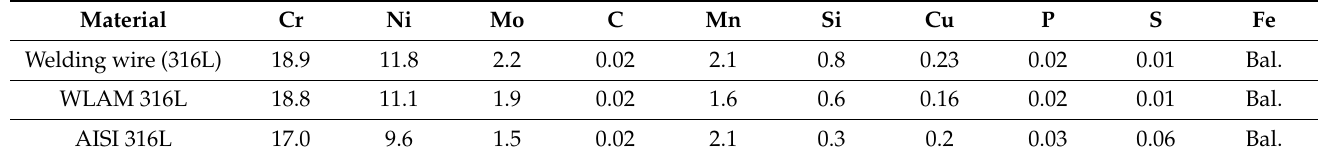
Table 2. Chemical compositions (wt.%) of the welding wire, WLAM 316L samples and counterpart AISI 316L alloy. Material